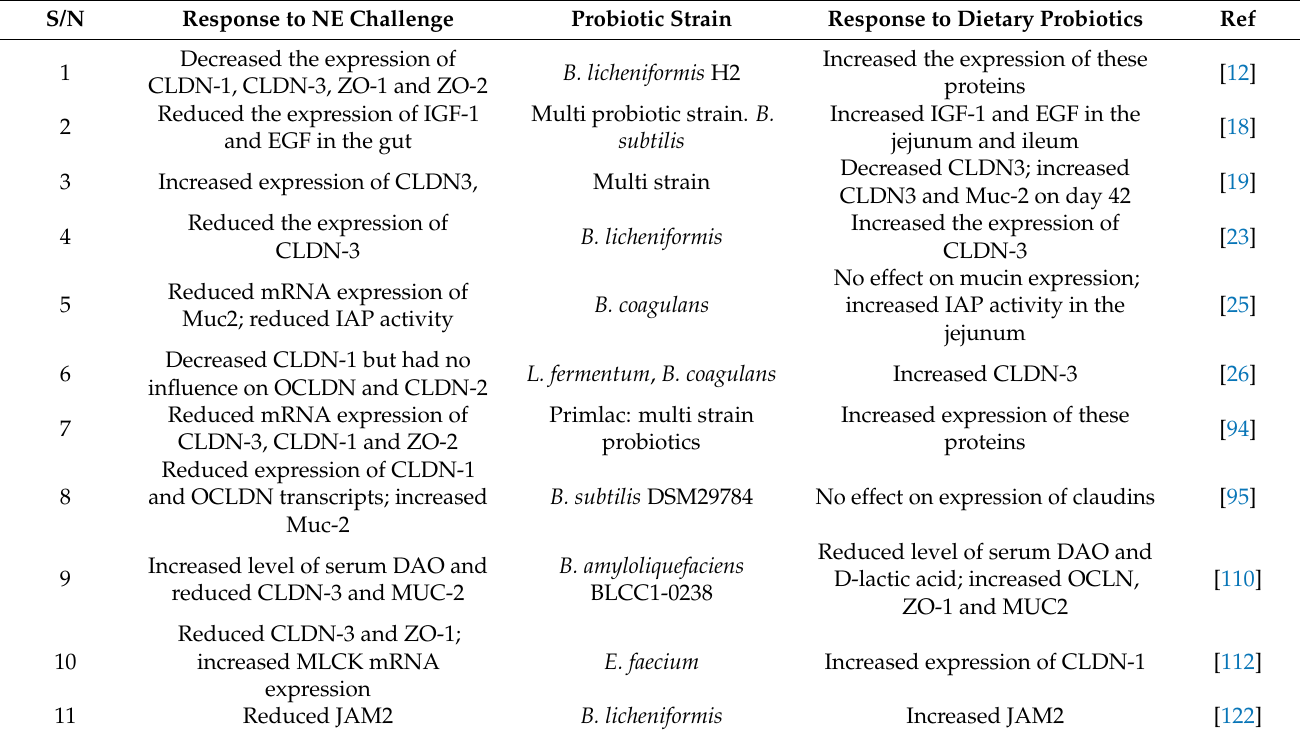
Table 3. Influence of NE challenge on intestinal barrier function and modulation effects by